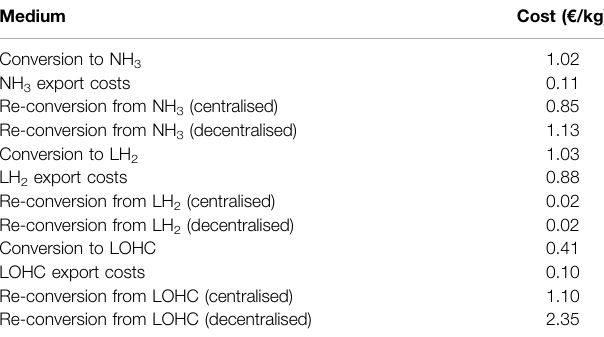
TABLE3| Costsofconversionandre-conversionfromandtogaseousH 2 ,aswell as export costs for each medium (International Energy Agency, 2019).